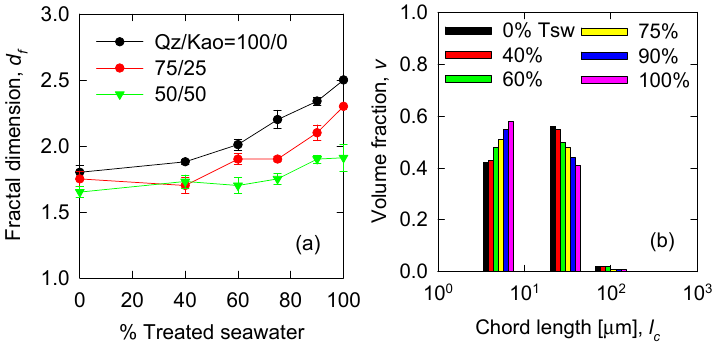
Figure 1. ( a ) Fractal dimension of flocculated aggregates and ( b ) initial volume particle distribution of qz/kao 75/25. Solid concentration 13 wt%, flocculant dose 15 g/t (for fractal dimension), mixing intensity 188 s − 1 .